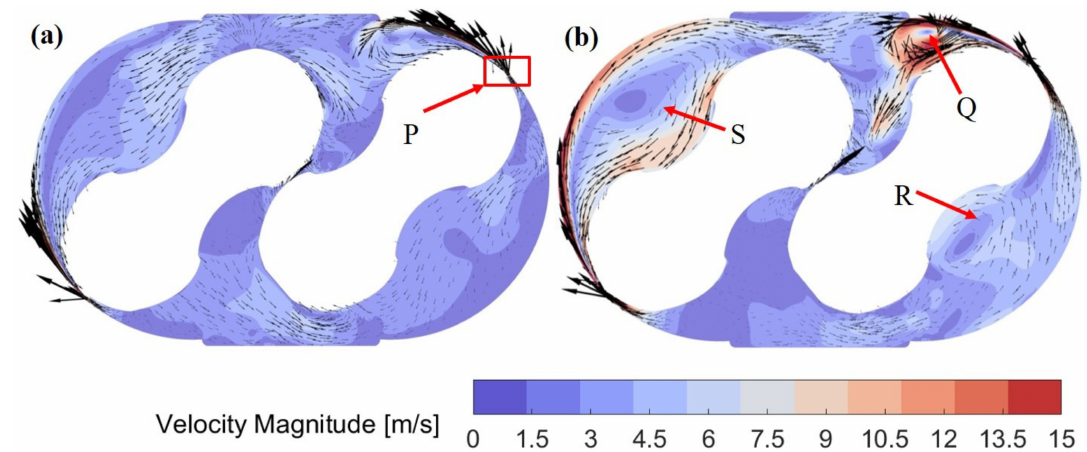
Figure 12. The overall flow field on the laser plane at 43 ◦ under pressure ratio 1.015 ( a ) and 1.072 ( b ).